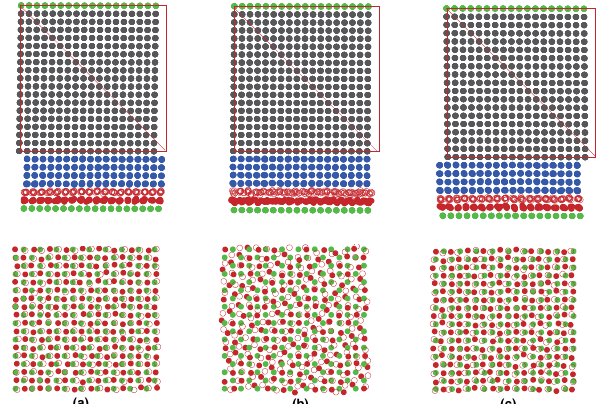
Fig. 13 Atomistic structures ( x – z side view and x – y bottom view) of the three-layer molecular tribological system at (a)   0 3 , (b)  = 0.5, and (c)  = 0.8. The fluid atoms in the second and the third layers are represented by the open red spheres and squares, respectively. The wall, the elastic substrate, and the fluid atoms in the first layer are represented by the green, blue, and filled red spheres, respectively. The coarse-grained far region of the substrate is represented by the gray